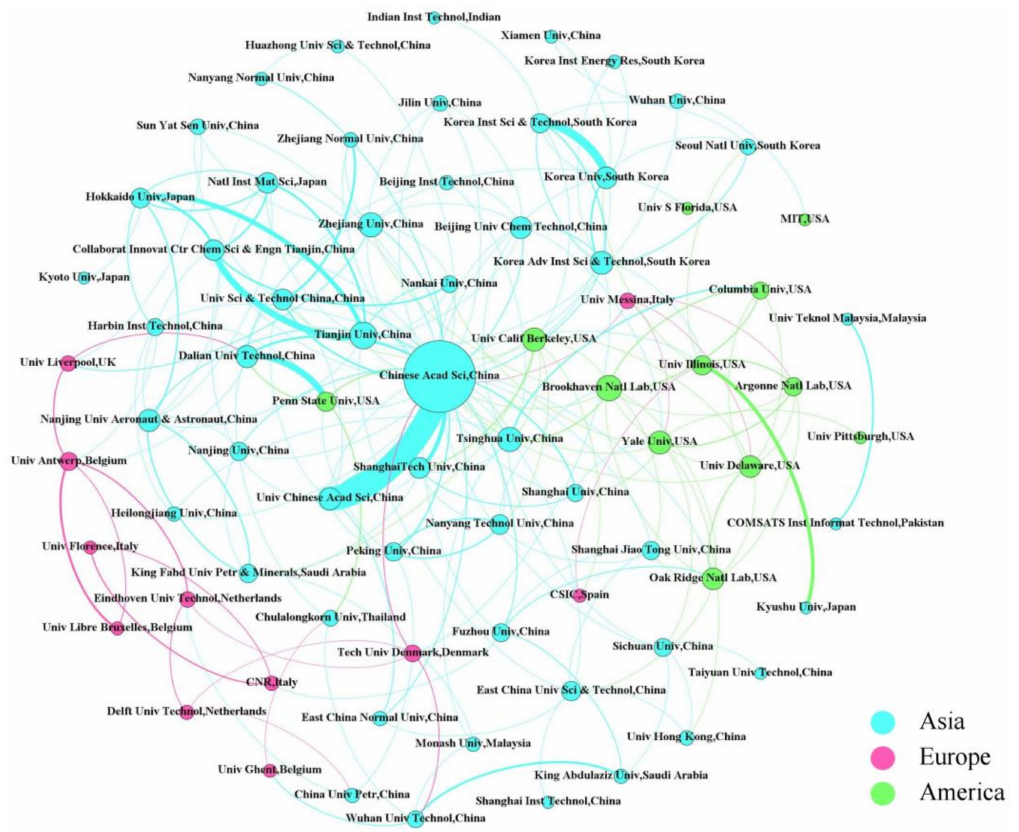
Figure 3. The collaboration network of 75 institutions (TP >